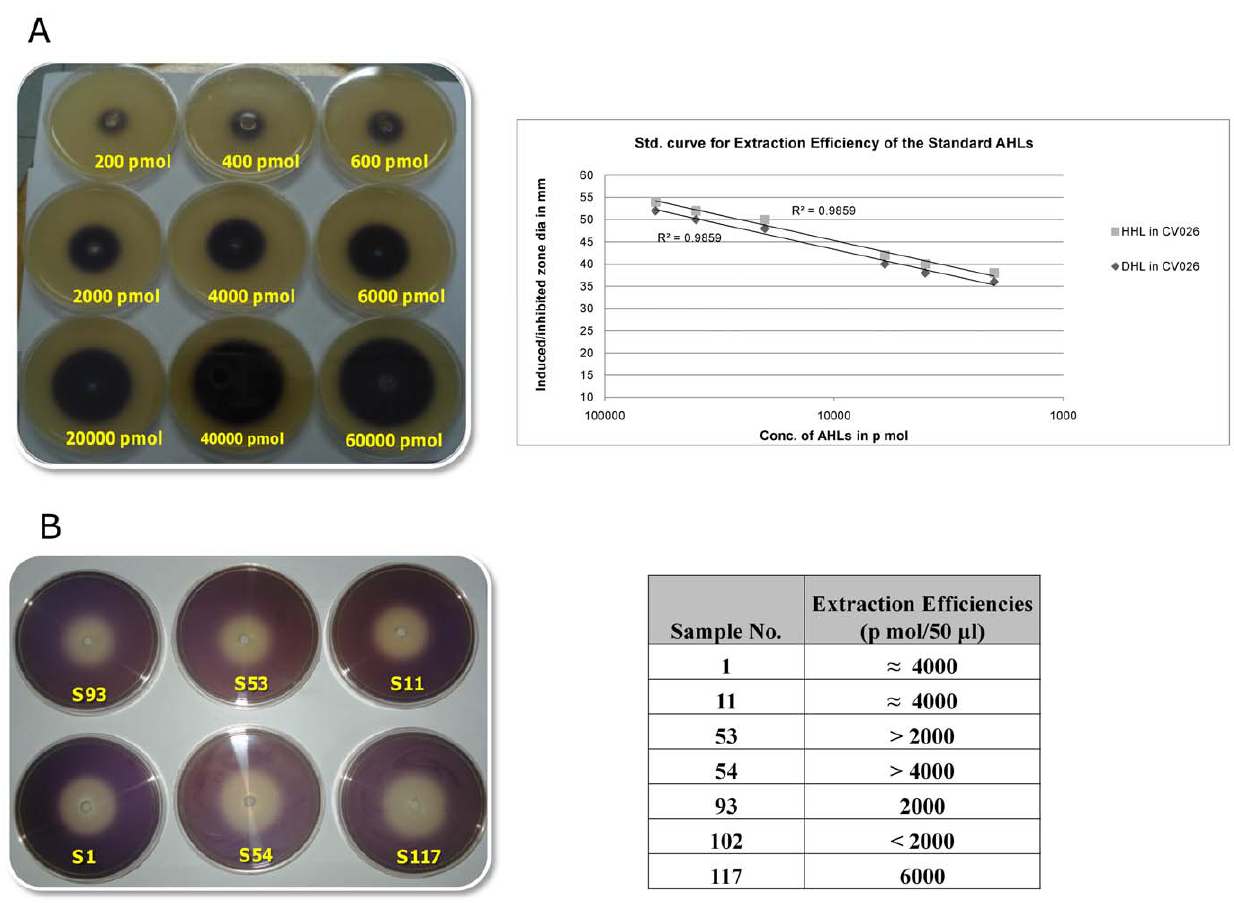
Figure 3. (A) Chromobacteriumviolaceum CV026 well-diffusion assay in LB agar. N- hexanoyl homoserine lactone (HHL) was added to wells in agar containing Chromobacterium violaceum CV026. Zones of HHL-induced violacin production is seen surrounding the wells. Increasing concentration of AHL shows the increase in zone diameters. Standard curve showing the relationship between concentration of acylated homoserine lactone ( N- hexanoyl homoserine lactone (HHL) & N- Decanoyl homoserine lactone (DHL)) and resulting diameters of induced/inhibited zones in Chromobacterium violaceum CV026 monitor system. (B) Well-diffusion assay for the tested isolates. Extraction efficiencies were tested on supernatants from Acinetobacter strains. Yields obtained were in the range of 1 6 10 2 9 moles to 6 6 10 2 9 moles of AHLs.